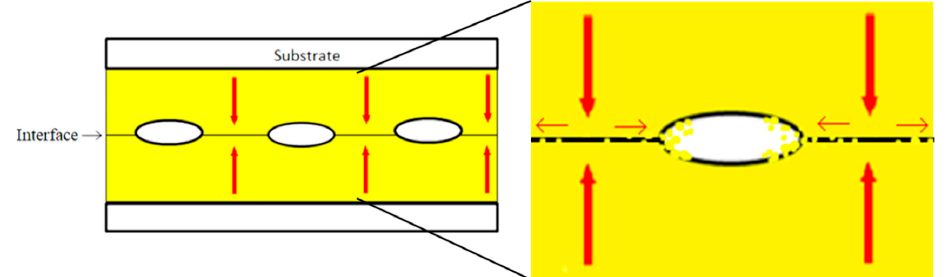
Figure 10. Schematic diagram of bonding mechanism at interface; a stress gradient forms between that of contacted areas (higher gradient) and voids (lower gradient), with the atoms then driven to diffuse along the interface to “fill” voids. The high surface diffusivity of the (111) surface is the main contributor to this phenomenon.